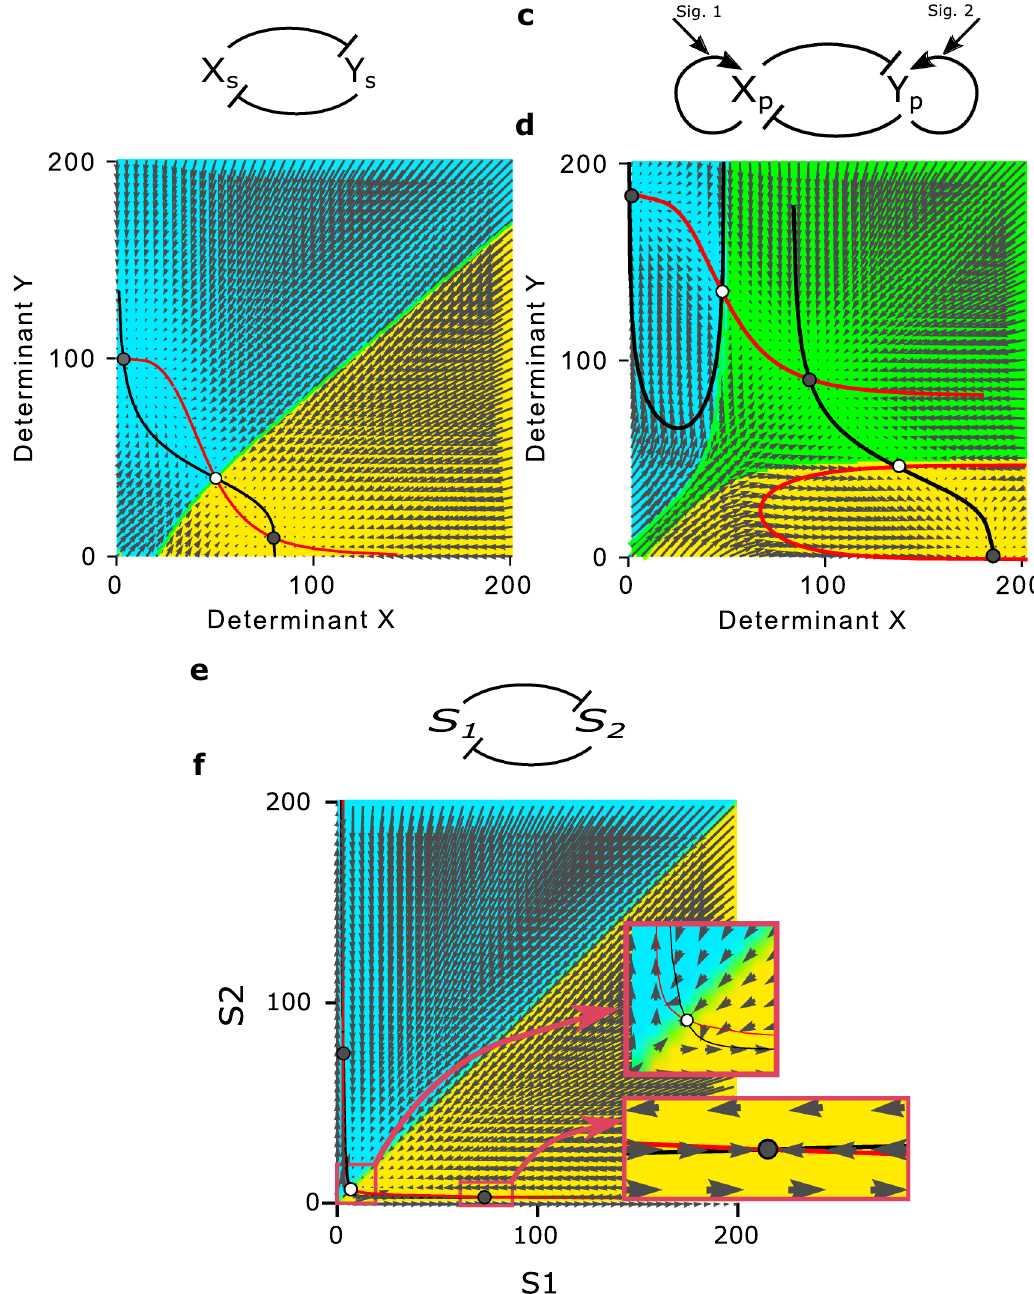
Figure 1. The model’s regulatory networks together with their corresponding force-field representations. The nullclines are drawn in red and black ( a ) A bi-stable regulatory network. ( b ) The stem cell’s force-field representation. ( c ) A tristable regulatory network. ( d ) The progenitor cell’s force-field representation. ( e ) The signalling molecules’ bi-stable regulatory network. ( f ) The signalling molecules’ force-field representation. Two critical zones around two attractors in the field are zoomed in in two red